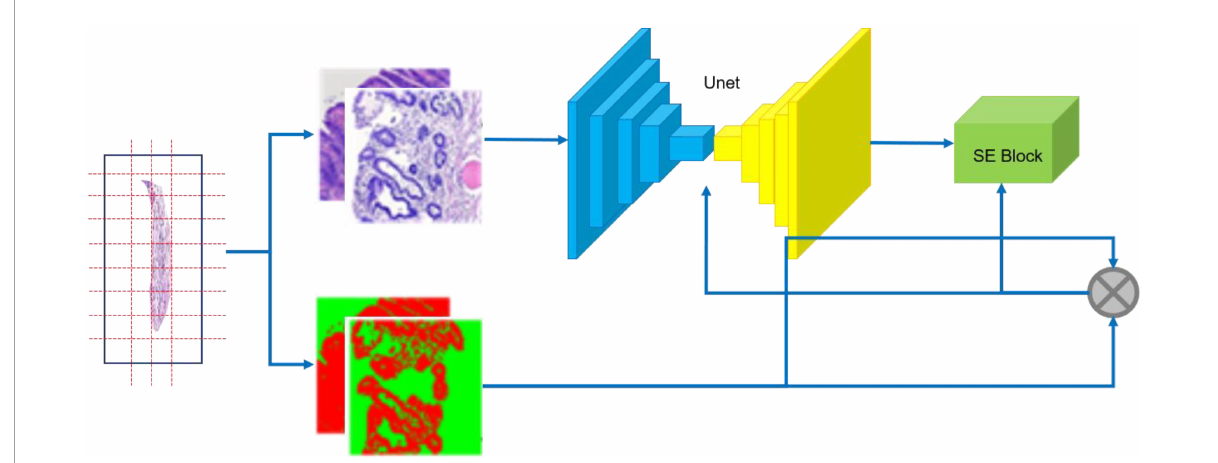
FIGURE5 Training flow of CNN. The specimen (left) is photographed; the resulting whole slide images are annotated (middle) ; image-label pairs are fed into the segmentation network (right) , which consists of the U-Net and the Squeeze and Excitation (SE) Block.